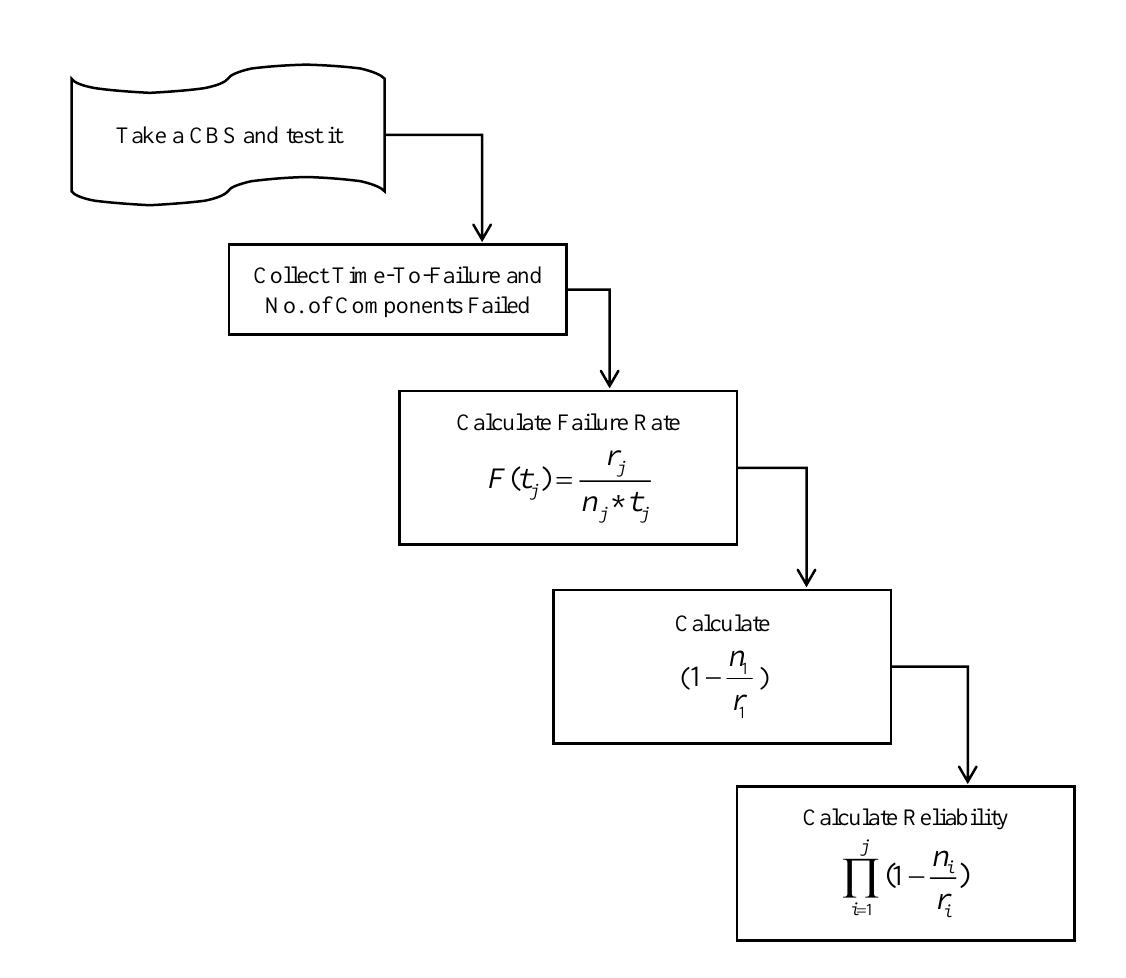
Figure 1. Flow chart for proposed